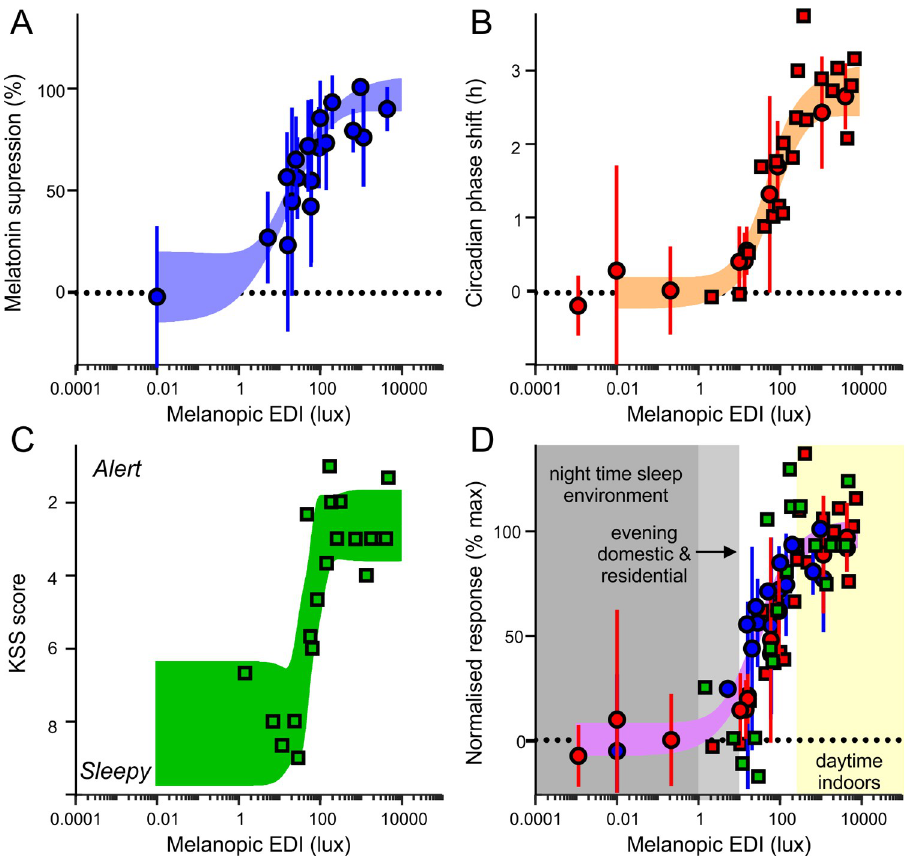
Fig 2. Recommendations for melanopic light exposures in relation to the sensitivity of melatonin suppression, circadian phase resetting, and subjective alerting responses. Data are derived from laboratory studies (in humans without the use of pupil dilators) investigating the impact of long exposures ( > 2 hours) to primarily broadband light sources on melatonin suppression [69,88,95,143,144] ( A ), circadian phase resetting [83,89,143,144]( B ), and subjective alerting responses [86] ( C ), as analysed in [38]. Group data (round symbols) are presented as mean ± SD; otherwise, data for individual subjects are presented (square symbols). Shading represents the 95% confidence limits of an unconstrained 4-parameter sigmoid fit to the data. For comparison across different response types ( D ), data sets from A – C were normalised relative to the range of the curve fit for that response type. Shaded areas in D reflect the consensus recommendations of the Second International Workshop on Circadian and Neurophysiological Photometry for sleep, evening, and indoor daytime environments. Recommendations are intended to provide realistic targets that minimise inappropriate nonvisual responses in the sleep environment (melanopic EDI < 1 lux) and reduce these so far as is practically possible presleep (3 hours before habitual sleep; melanopic EDI < 10 lux) while maximising relevant effects across the intervening daytime hours (melanopic EDI > 250 lux). The nonshaded region indicates the range of melanopic EDI that should, where possible, be avoided during evening and nighttime and are considered suboptimal for daytime environments. EDI, equivalent daylight